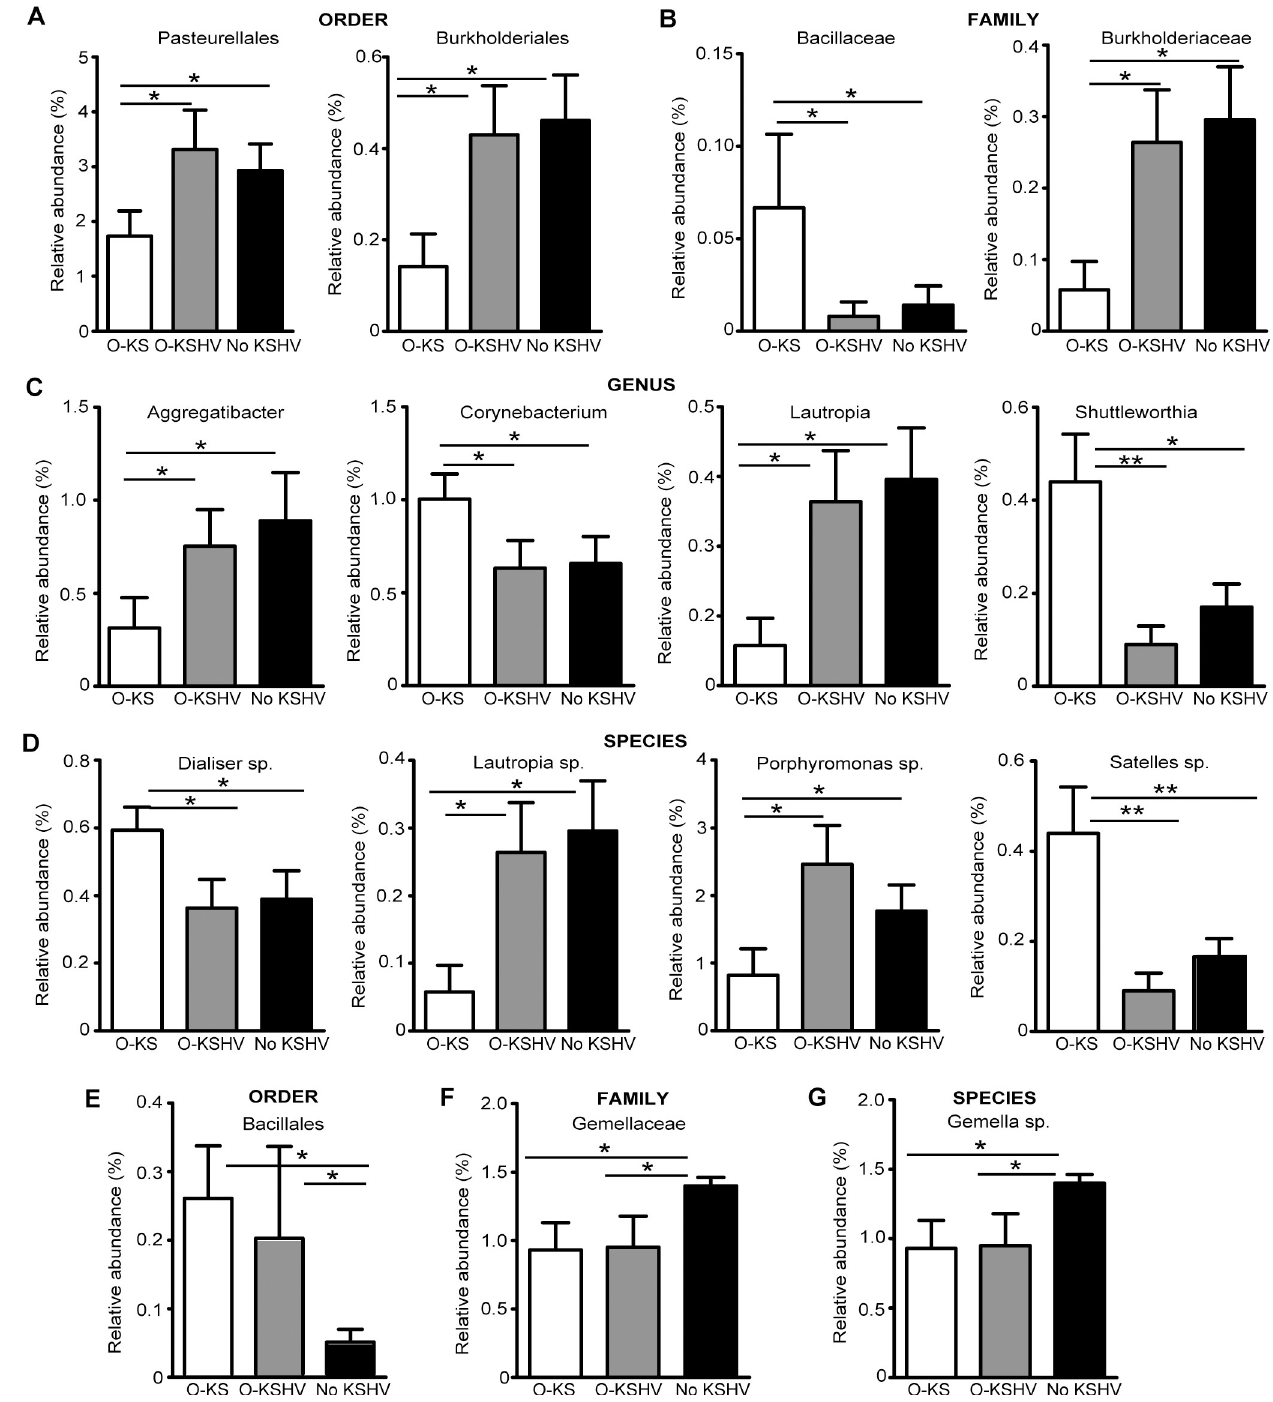
Fig 4. Alterations of oral microbiota in HIV/KSHV-coinfected individuals with oral cell-associated KSHV DNA or oral KS. (A-D) Distinct signatures of O-KS group shown by relative abundances of OTUs at order level (A), family level (B), genus level (C) and species level (D). (E-G) Distinct signatures of No KSHV group shown by relative abundances of OTUs at order level (E), family level (F) and species level (G). Statistical analysis was performed using Student’s t-test with the GraphPad Prism software. Only significant results are represented.